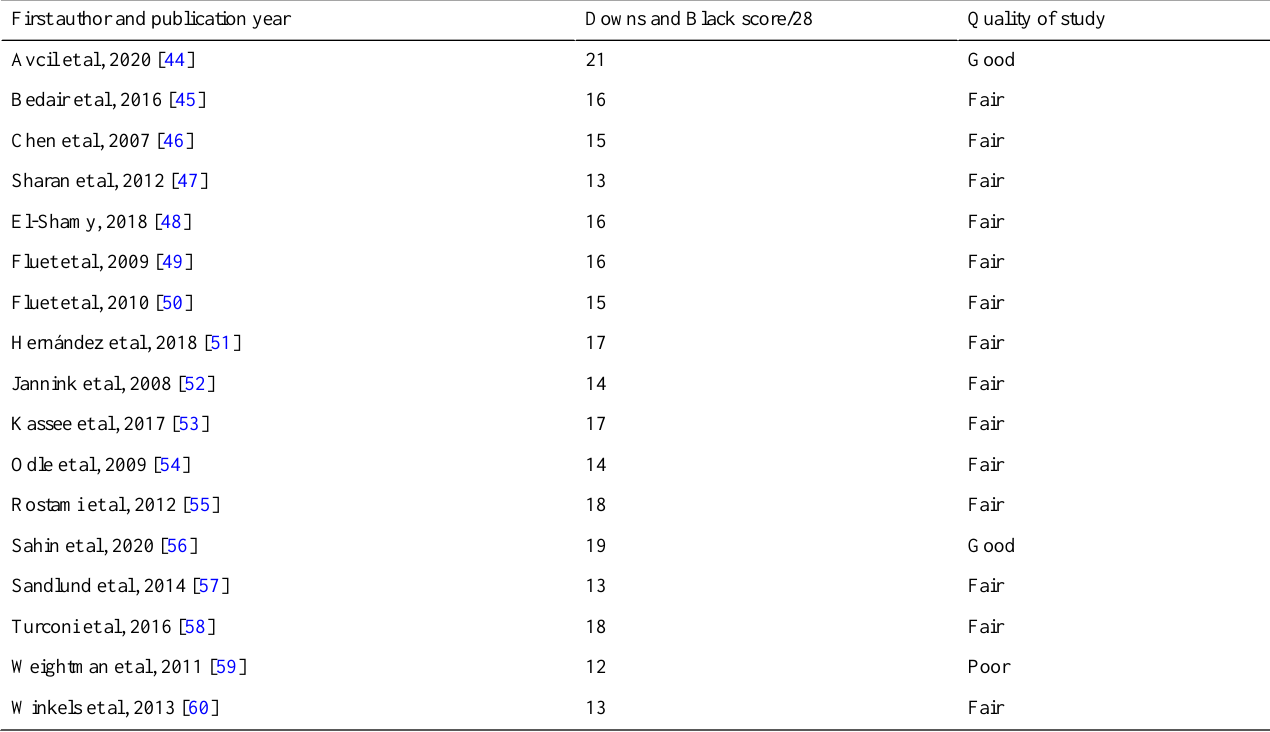
Quality of studyDowns and Black score/28First author and publication